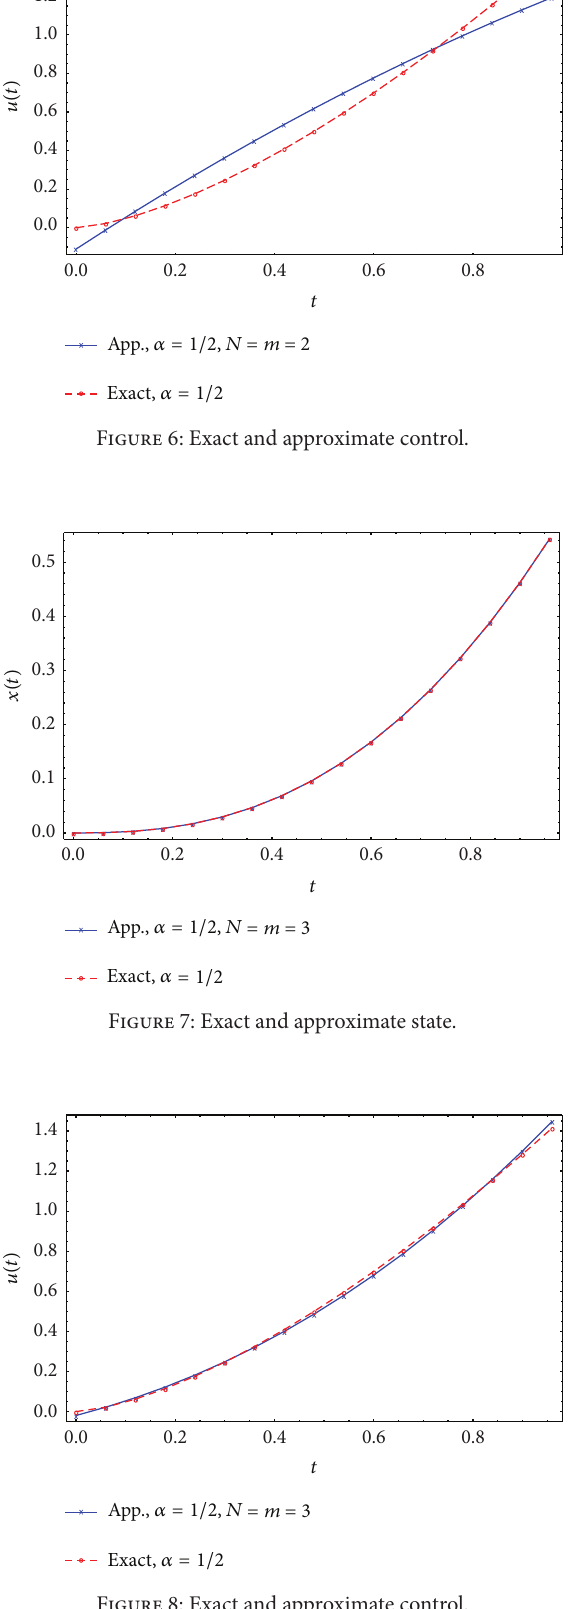
Figure 8: Exact and approximate control.